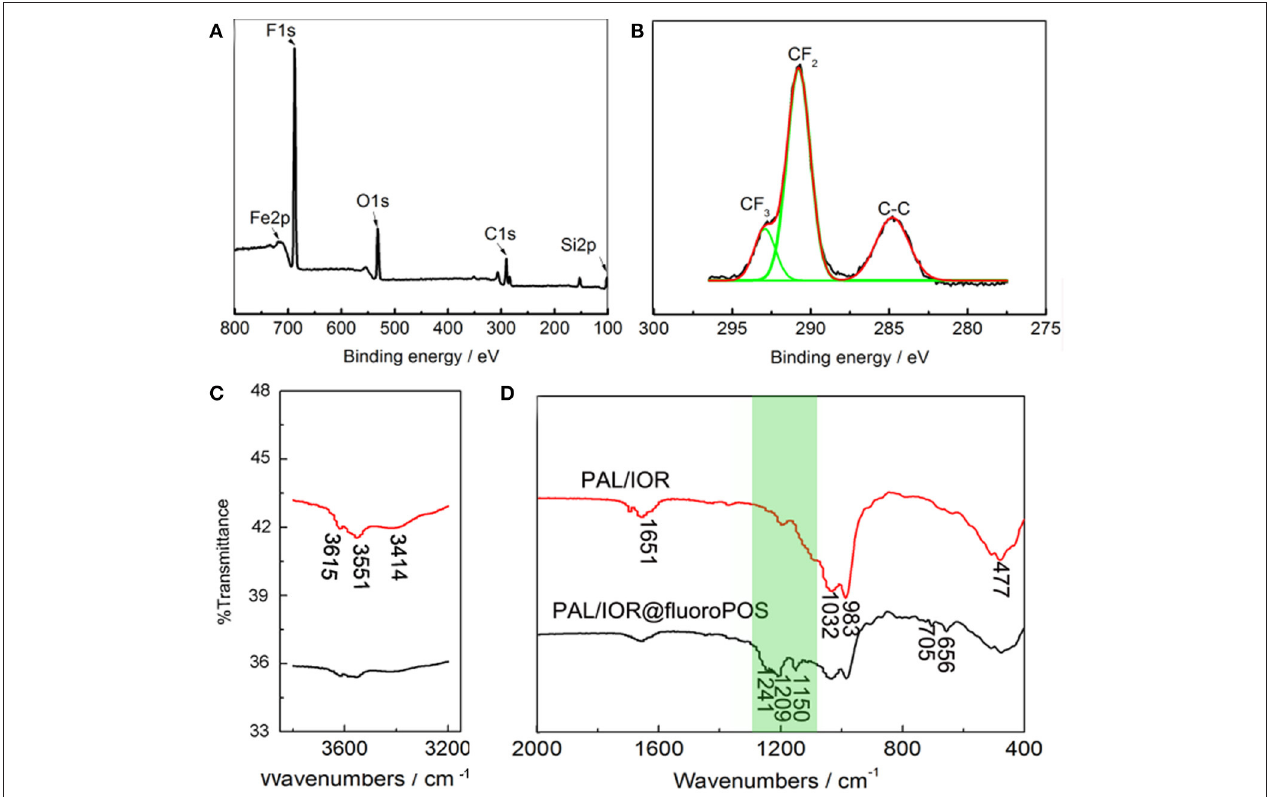
FIGURE 3 | (A) XPS spectra, (B) high-resolution C 1s XPS spectrum and (C,D) FTIR spectra of the PAL/IOR@fluoroPOS coatings. C PAL / IOR = 14g L − 1 , t grinding = 20min, C PFDTES = 27.2mM, C TEOS =